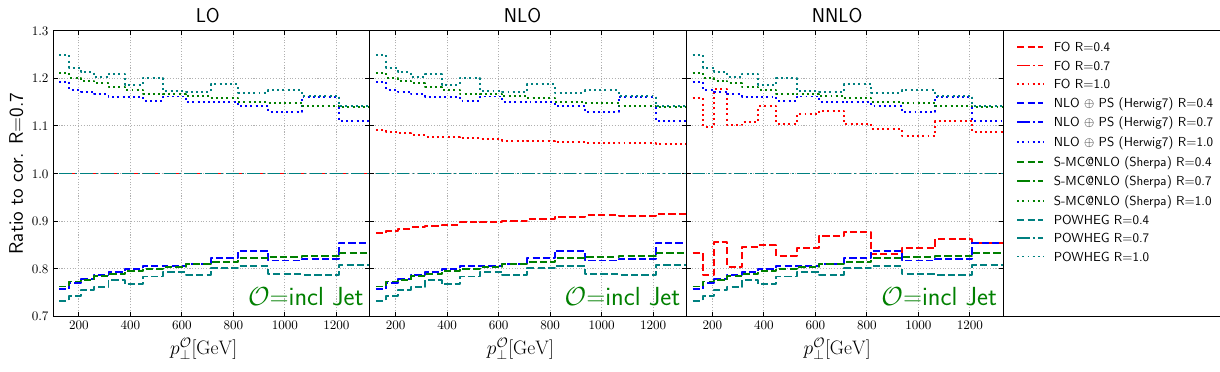
Fig. 12 The ratio of each cross section (either Higgs( Z ) p T or lead jet p T ) for specific jet sizes, scaled to the cross section for each prediction for a jet size of R = 0 . 7